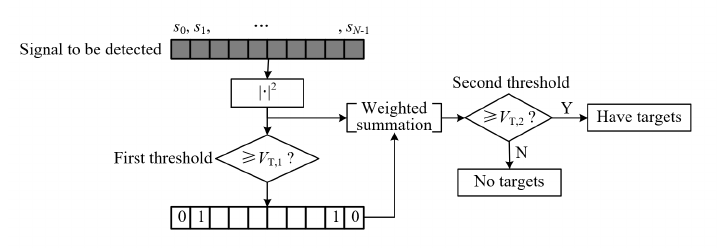
Figure 8. Schematic diagram of single double-threshold detection